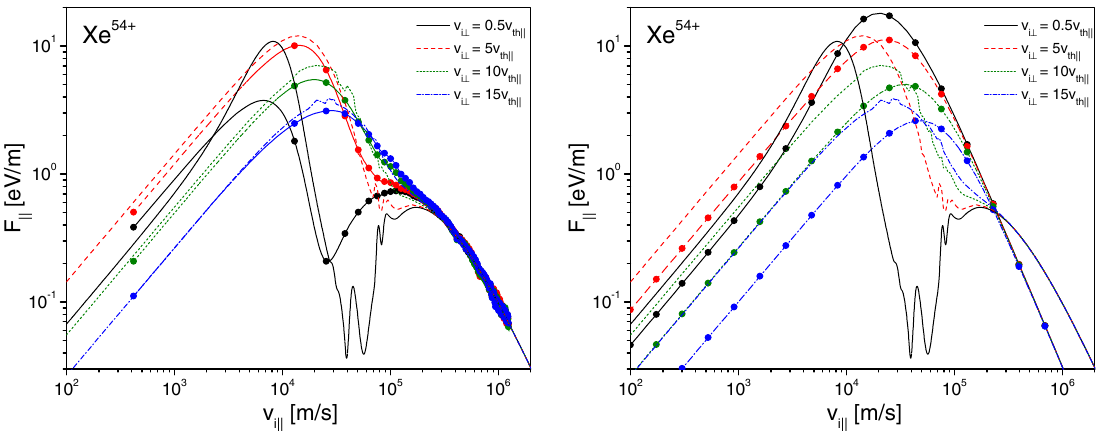
FIG. 6. Same as in Fig. 5 but for Xe 54 þ ion. In the right panel the PF is evaluated with v eff ¼ 3 : 5 v th k .